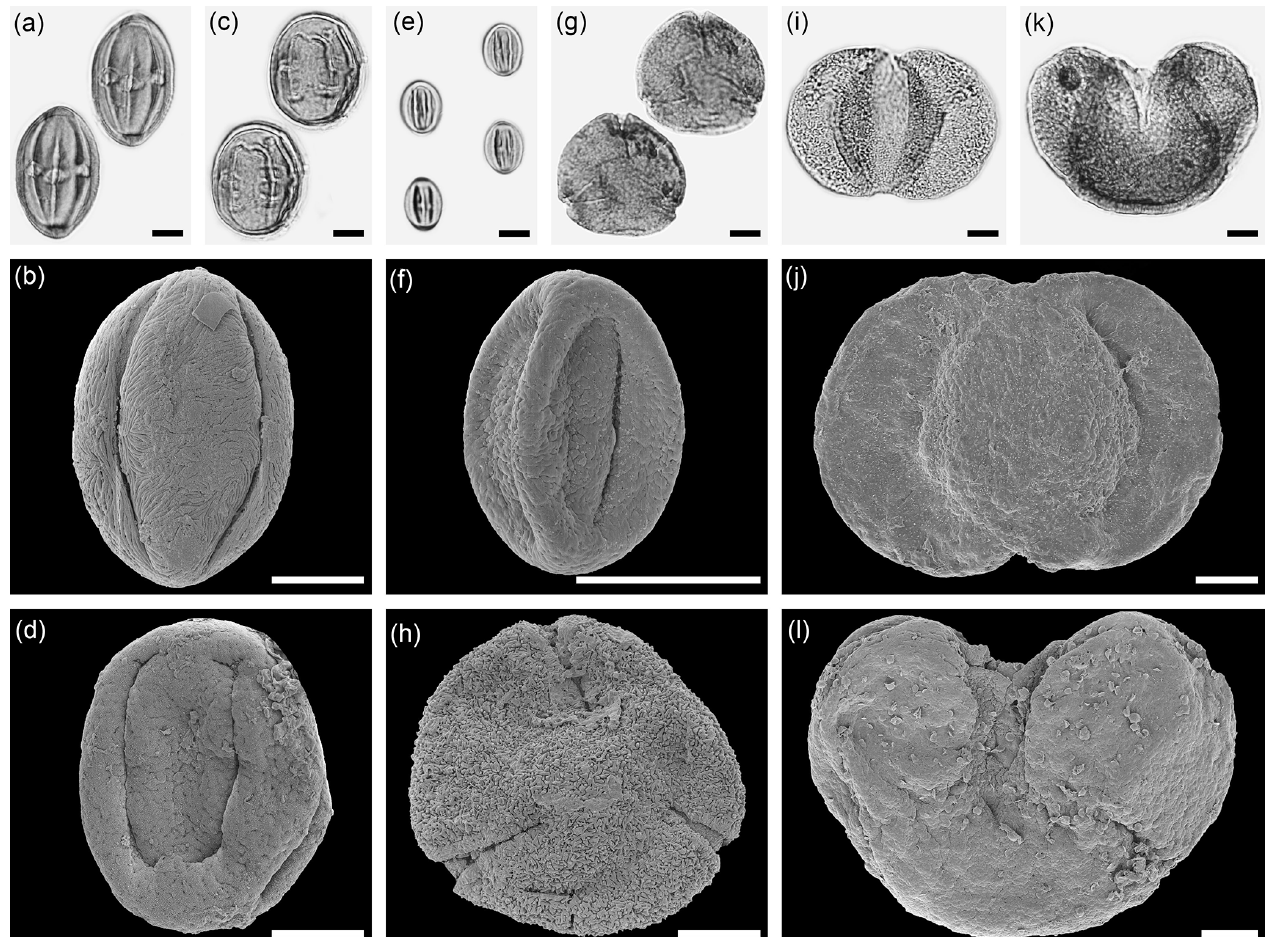
Figure 4. Selected pollen grains light microscopy (LM) (a, c, e, g, i, k) and scanning electron microscopy (SEM) (b, d, f, h, j, l) micrographs of the same fossil pollen grain of the Eskihisar (E), Tınaz (T), and Salihpa¸salar (S) sections. (a–b) Nitraria sp., EV (E, S153567). (c–d) . Sapotaceae gen. indet., EV (T, S143604). (e–f) Decodon sp., EV (S, S153635). (g–h) Fagus sp., PV (T, S143621). (i–j) Cathaya sp., (i) PV, (j) PRV (S, S153632). (k–l) Cedrus sp., EV (E, S153590). EV: equatorial view; PV: polar view; PRV: proximal view. Scale bar: 10µm (a–l)